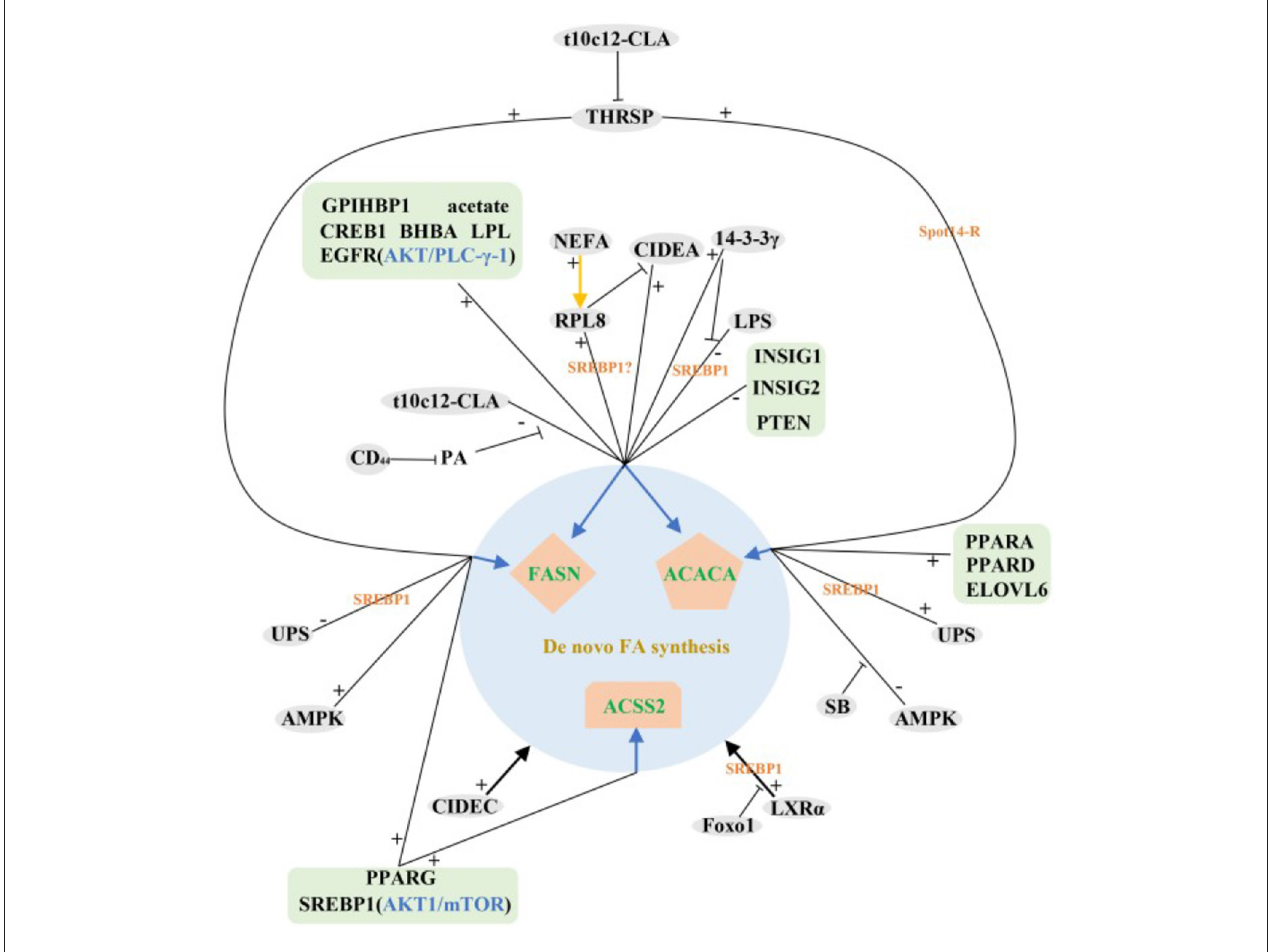
FIGURE 2 | Regulatory network of de novo milk fat synthesis in ruminants. + : Positive regulation; –: Negative regulation; : Inhibition; : It can regulate FASN, ACACA and ACSS2 genes; : Regulate a